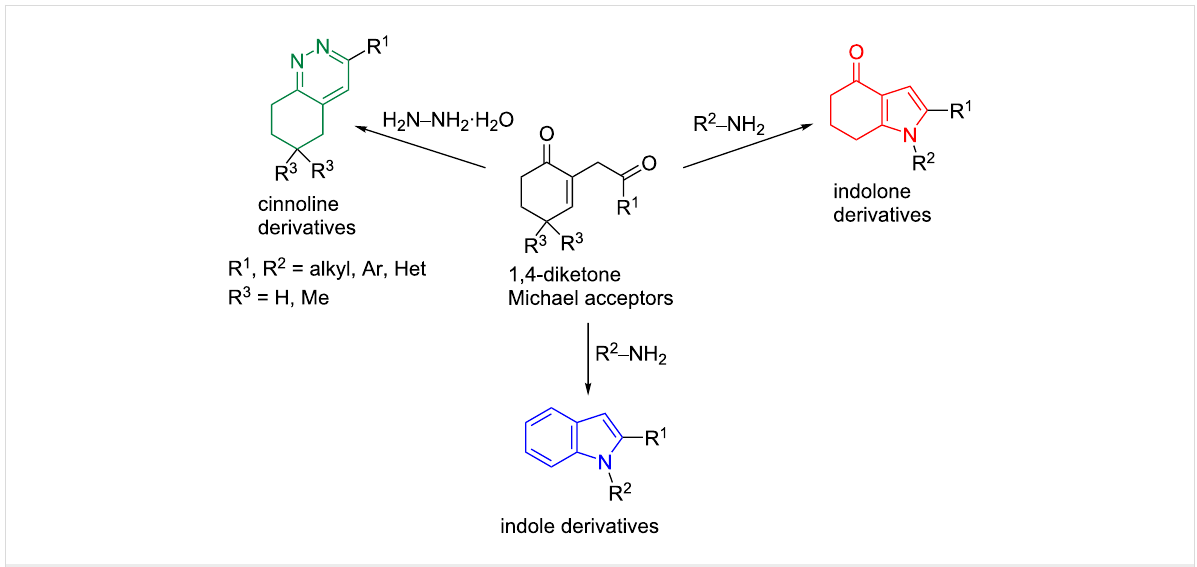
access indolone derivatives, mainly based on the use of di- [12,38,39] or triketones [10,13] and enaminones [40-43] as starting materials. For the synthesis of cinnoline derivatives, aryldiazenes and aryltriazenes are substrates of choice for tran- sition-metal-catalyzed (Rh, Pd, Cu) cross-coupling